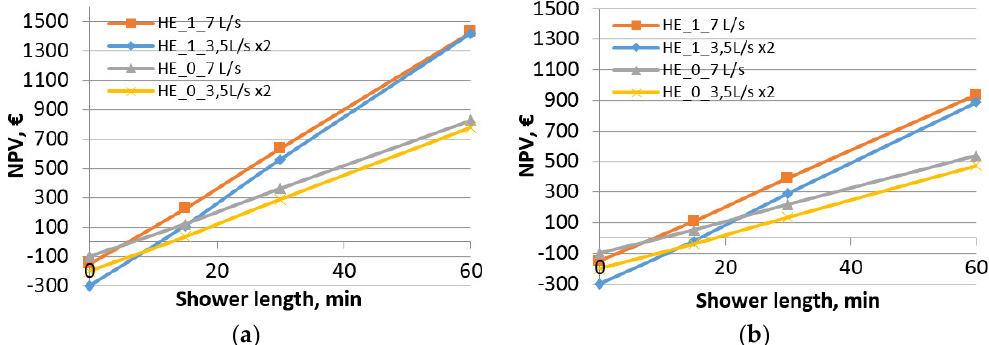
Figure 10. Dependence of NPV on shower length: ( a ) Scenario A (365 days); ( b ) Scenario B (261 days). In turn, in scenario B (assuming that the premises are used for 261 days a year) and a short time of use of less than 15 min, only the HE_0 and HE_1 heat exchanger solutions in Variant I showed a positive NPV result.